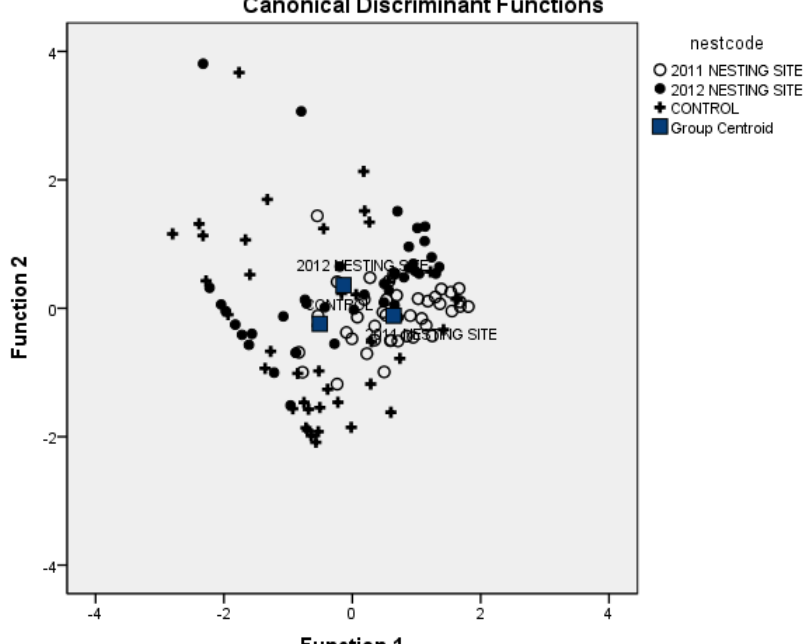
Figure 1. Canonical discriminant functions and their success in separating the three nesting sites (2011 nest, 2012 nest and control) for the significant vegetation variables used by Socotra Cormorants in the UAE.